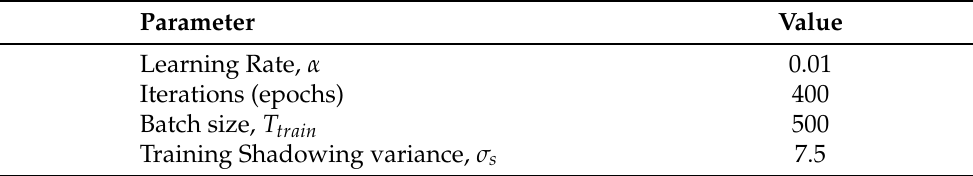
Table 1. Training parameters.